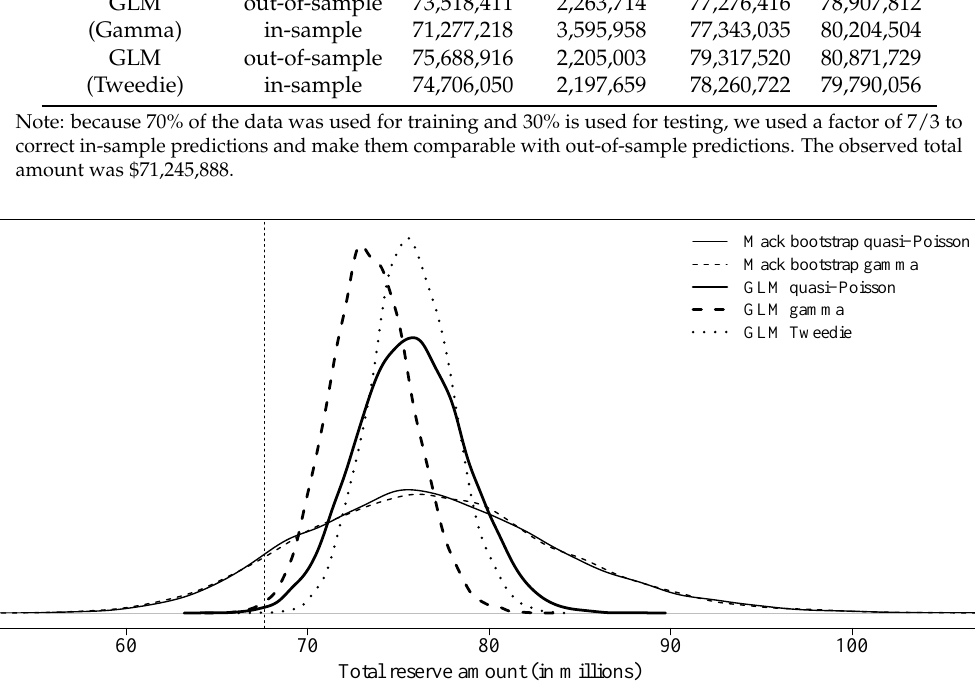
Figure 3. Comparison of predictive distributions (incurred but not reported (IBNR) + reported but not settled (RBNS)) for collective